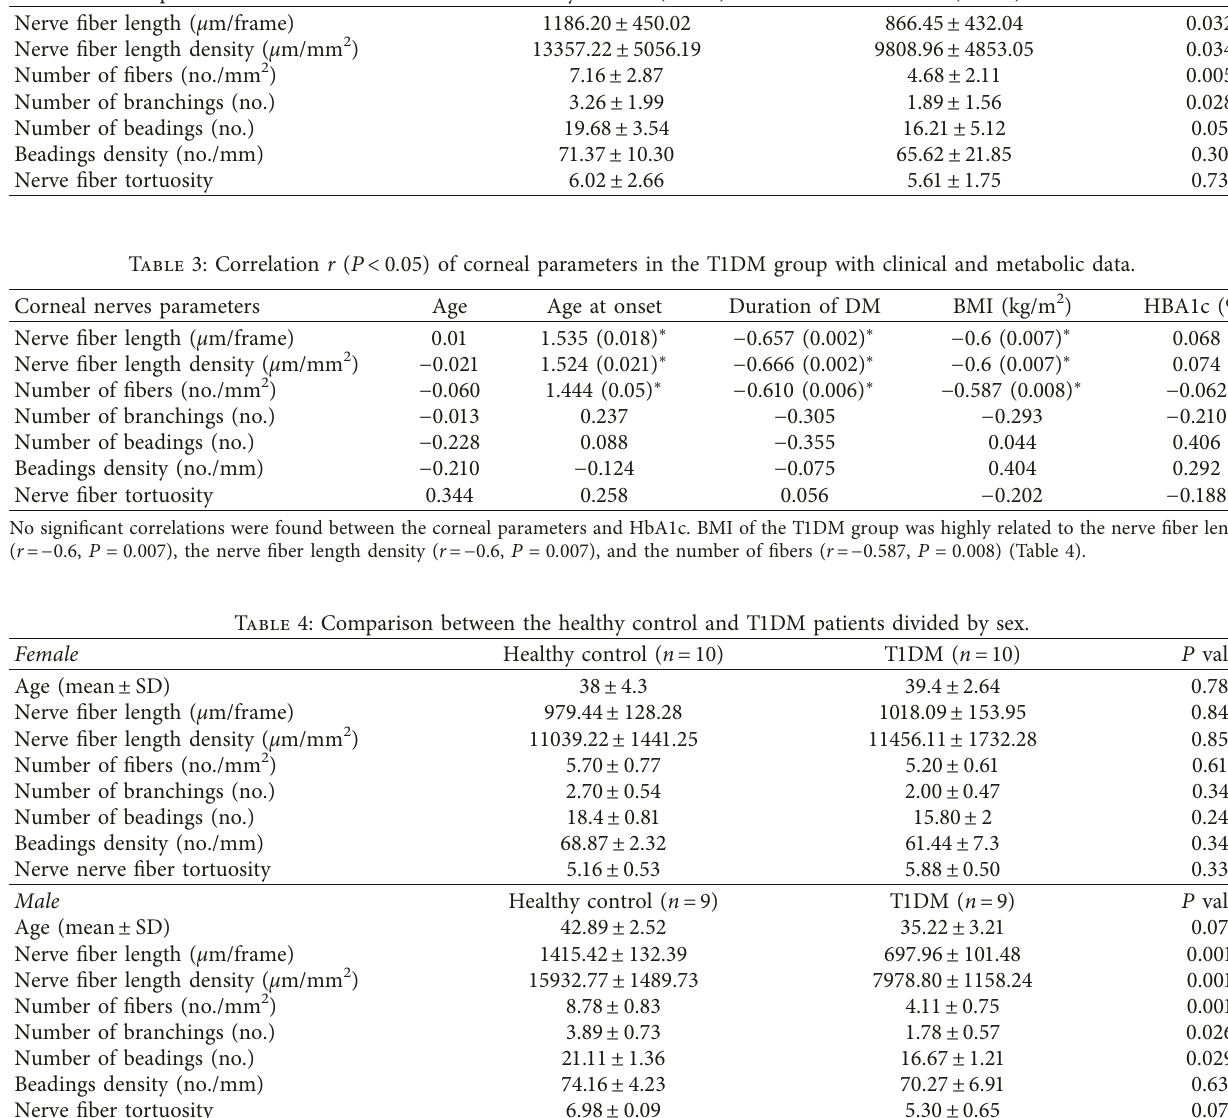
Table 2: Summary of corneal nerves morphological parameters in study population (T1DM versus healthy control). Corneal nerves parameters